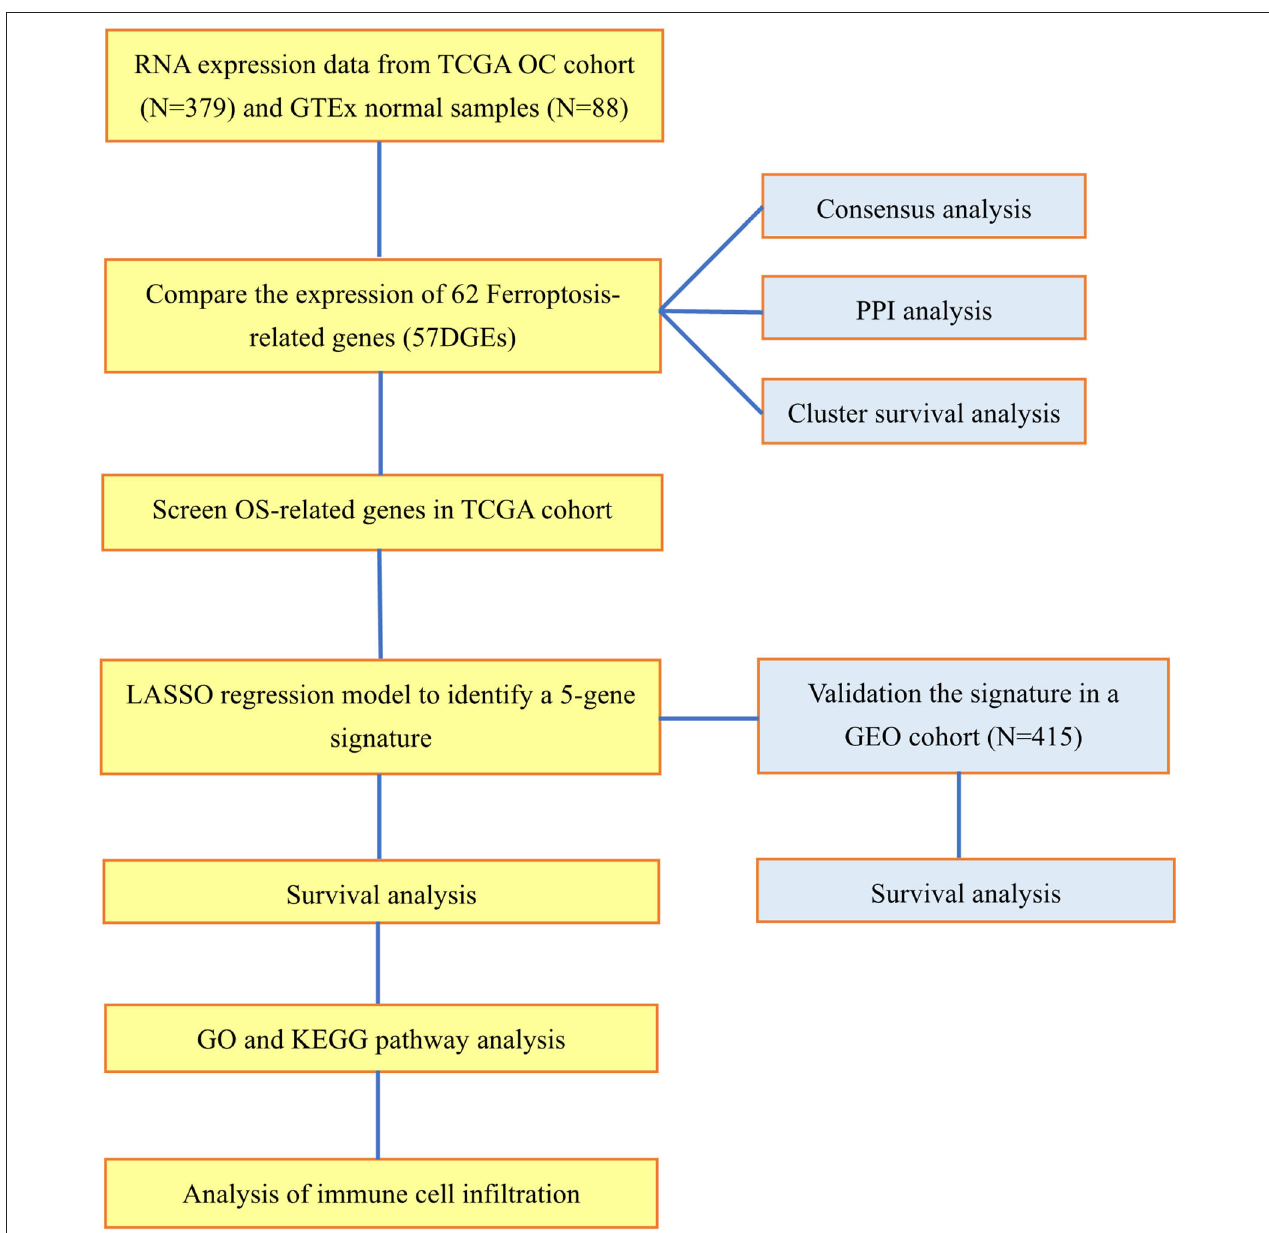
FIGURE 1 | Workflow diagraph of data collection and analysis.